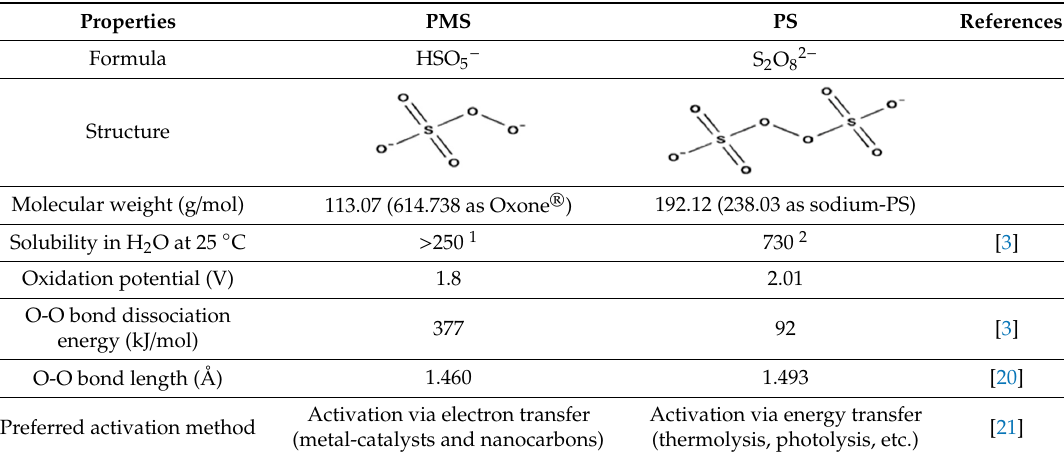
Table 2. Basic properties of PMS and PS.